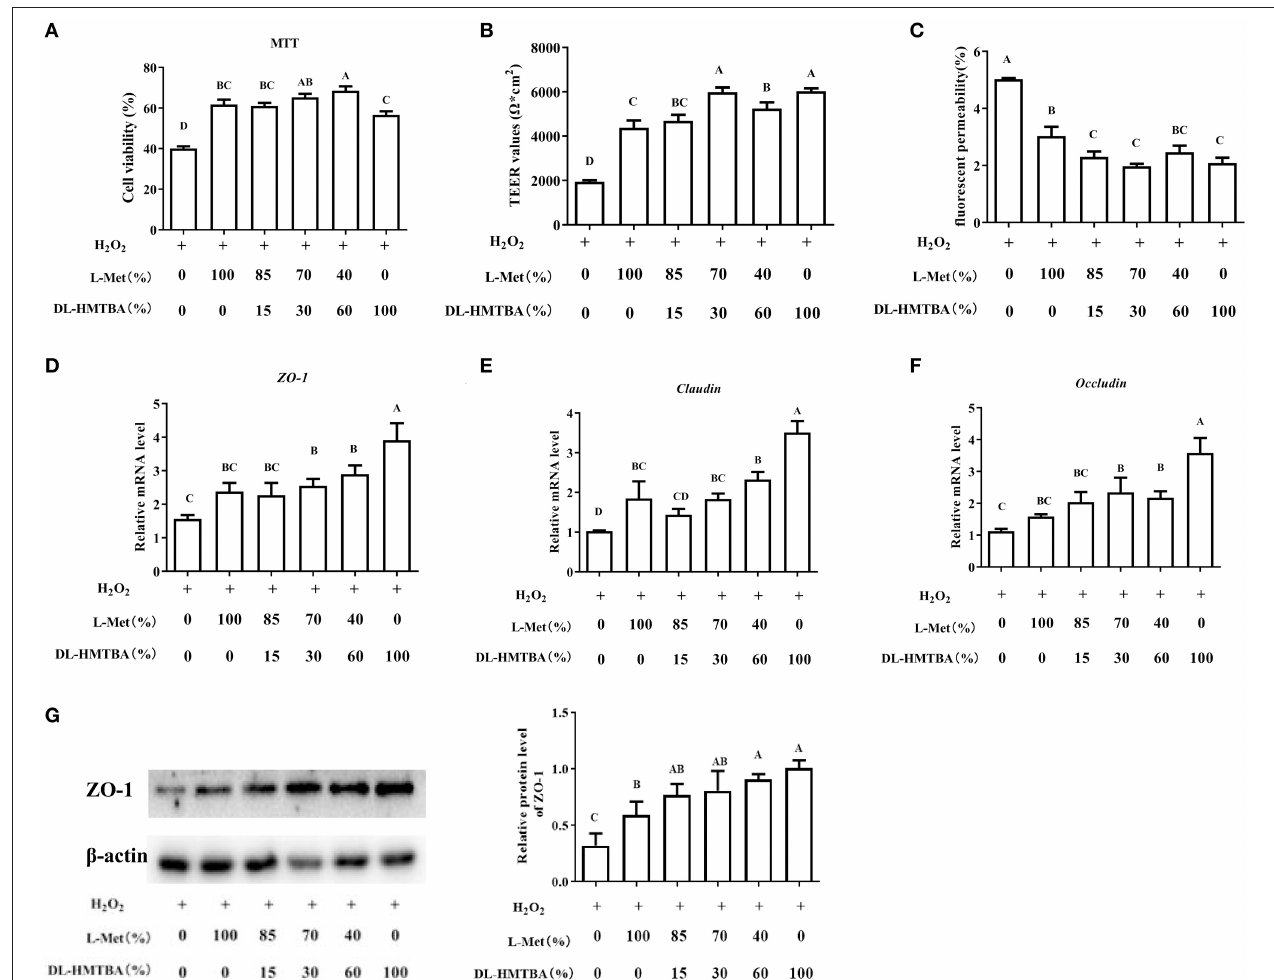
FIGURE 1 | Effects of different ratios of L-Met and DL–HMTBA on the barrier function in IPEC-J2 cells. (A) Cell viability after Met source intervention; (B) TEER values; (C) Fluorescent yellow permeability; (D) mRNA levels of ZO-1; (E) mRNA levels of Claudin; (F) mRNA levels of Occludin; (G) Protein level of ZO-1. Cells were cultured without fetal bovine serum for 18h and then without Met for 6h, then, different ratios of L-Met and DL–HMTBA were given for 2h (total methionine source concentration is 5mM), at last cells were treated with 0.8mM H 2 O 2 for 24h. Values are means ± SEM, n = 3; different letters (A–D) mean the difference is extremely significant, p <